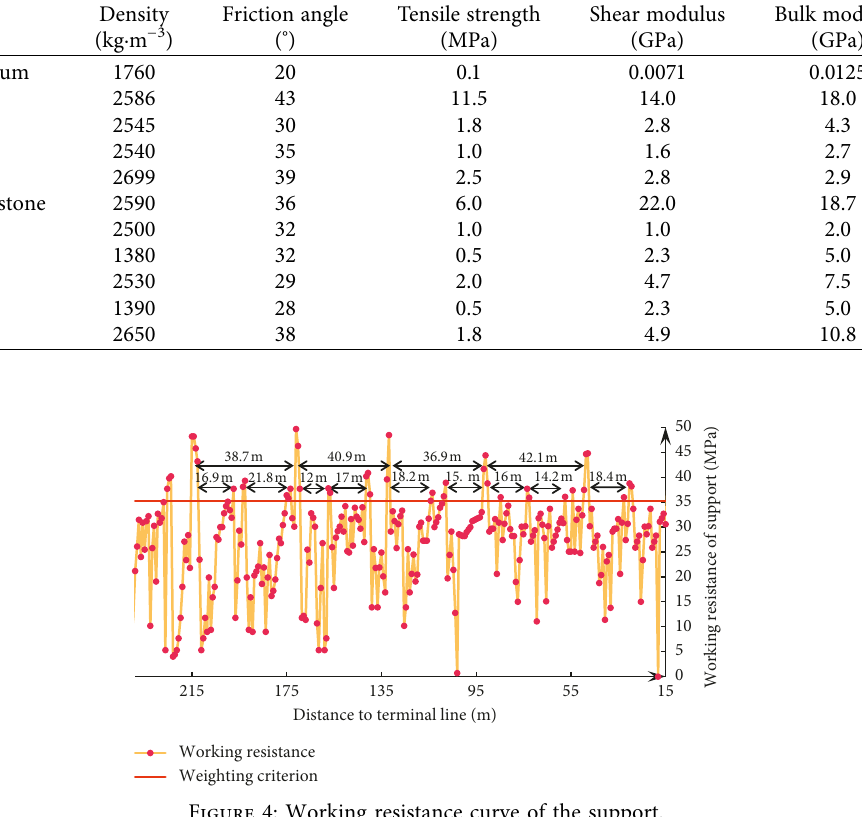
Table 1: Physical and mechanical parameters of the coal stratum.